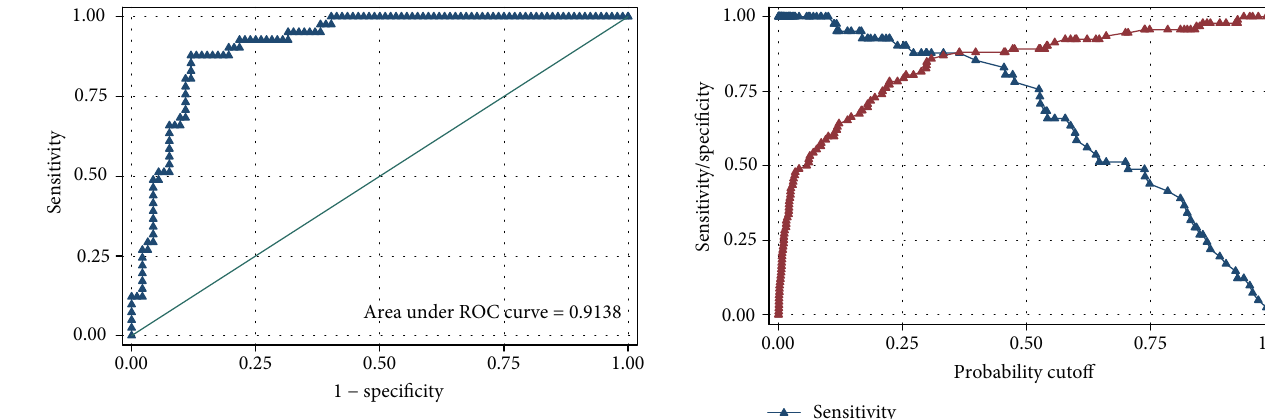
Figure 1: Postestimation ROC curve for the fi nal step of the model (the unit of the predictor is the scoring system).